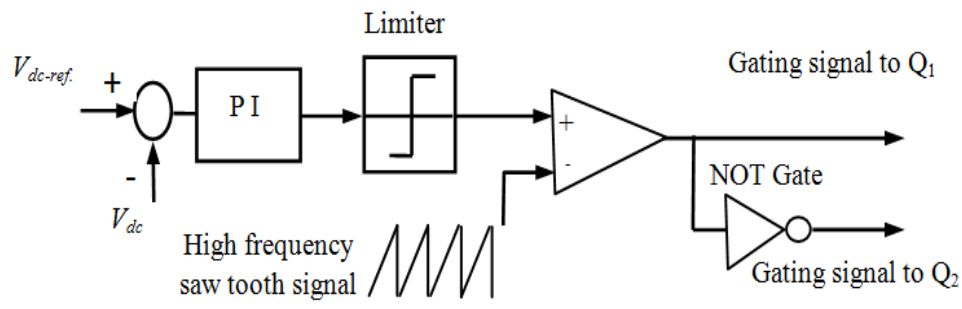
Figure 8. The DC-DC bidirectional converter control